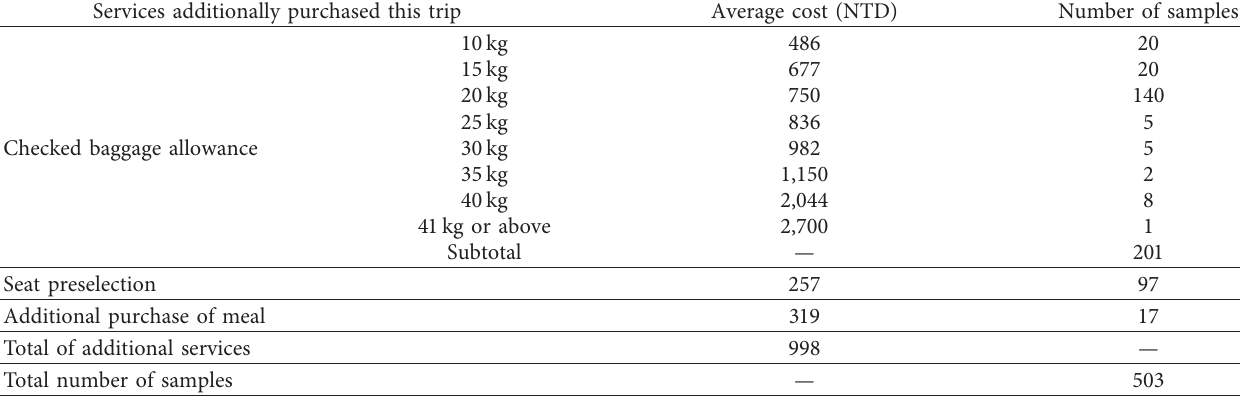
Table 3: Average cost of purchasing additional services this trip.